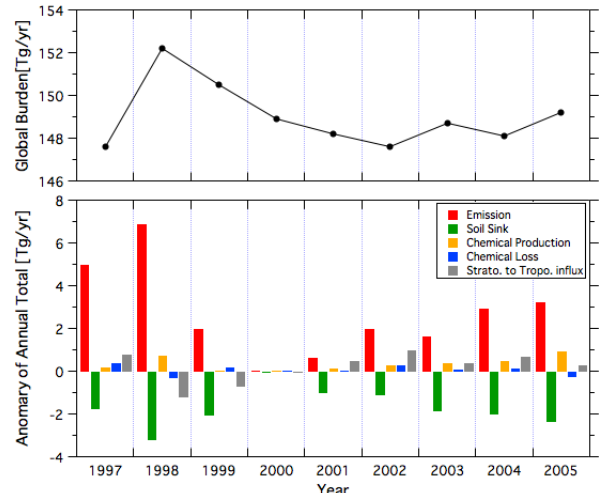
Fig. 8. Global annual averages of the sources and sinks of H 2 Fig. 8 Global annual averages of the sources and sinks of H 2 (lower panel) and (lower panel) and global burden of H 2 (upper panel) during the pe- global burden of H 2 (upper panel) during the period 1997 − 2005. Four riod 1997–2005. Four budget terms are expressed as anomaly from 2000, respectively, and the total sum of all the terms in 2000 is − 1.9Tgyr − 1